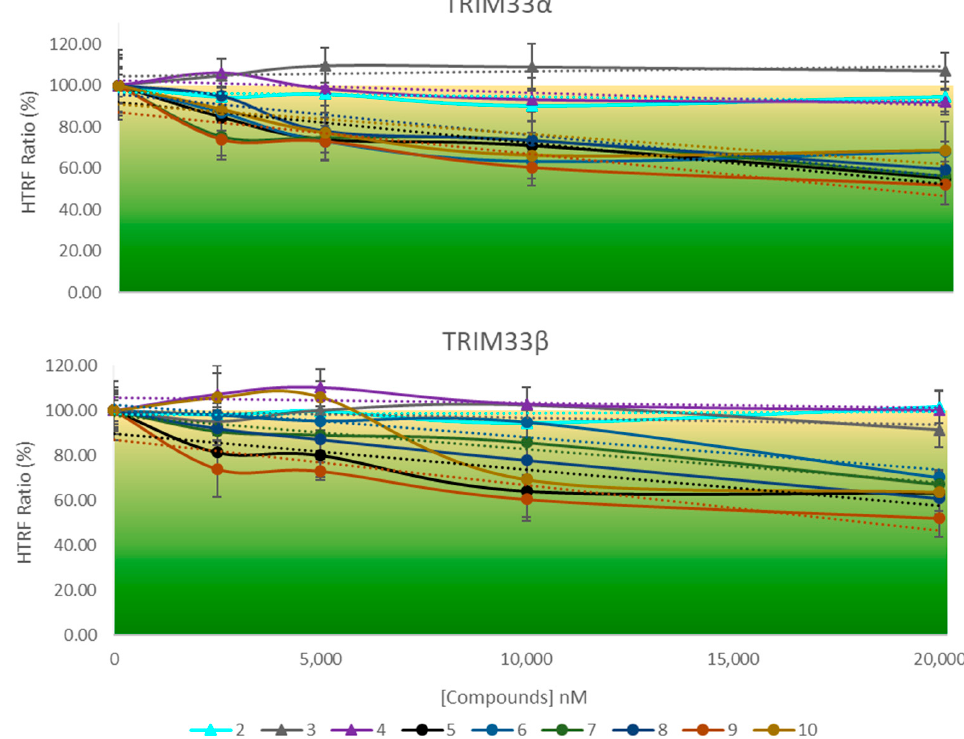
Figure 12. Dose-response HTRF competition assay against TRIM33 α and TRIM33 β . Curves related to compounds 2 , 3 , 4 , 5 , 6 , 7 , 8 , 9 , and 10 are reported with different colours. The HTRF ratio at different concentrations of the compounds and using a fixed peptide concentration (K d ) was detected. Values are the mean of three independent experiments ± standard error of the mean.